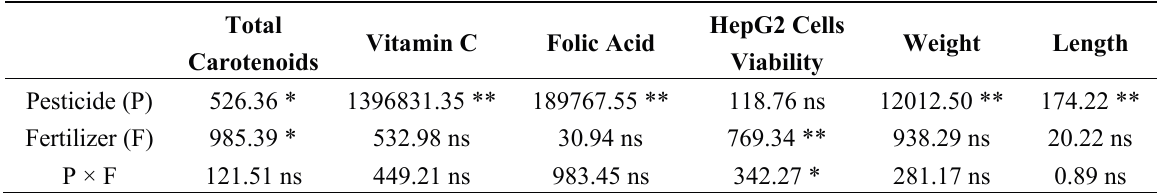
Table 4. ANOVA of means square for total carotenoids, vitamins, HepG2 cells viability, weight and length in